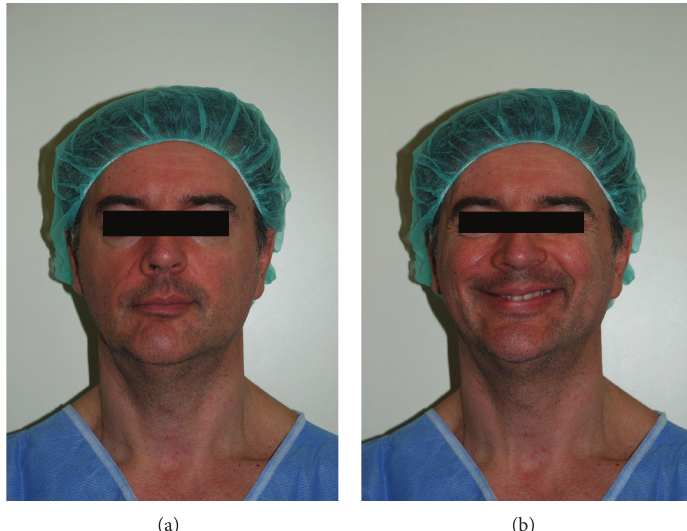
Figure 1: (a, b) Frontal view of our patient who presented with painful posttraumatic scar in the nasolabial fold. In (b), the partial motor impairment of the mouth movements can be